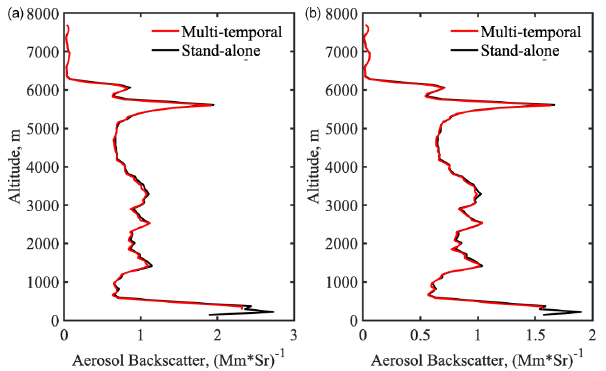
Figure 26. Aerosol backscatter profiles at 455nm (a) and 940nm (b) estimated from COBALD profiles acquired on 11 Au- gust 2015 using a stand-alone (black) and multi-temporal (red) re- trieval